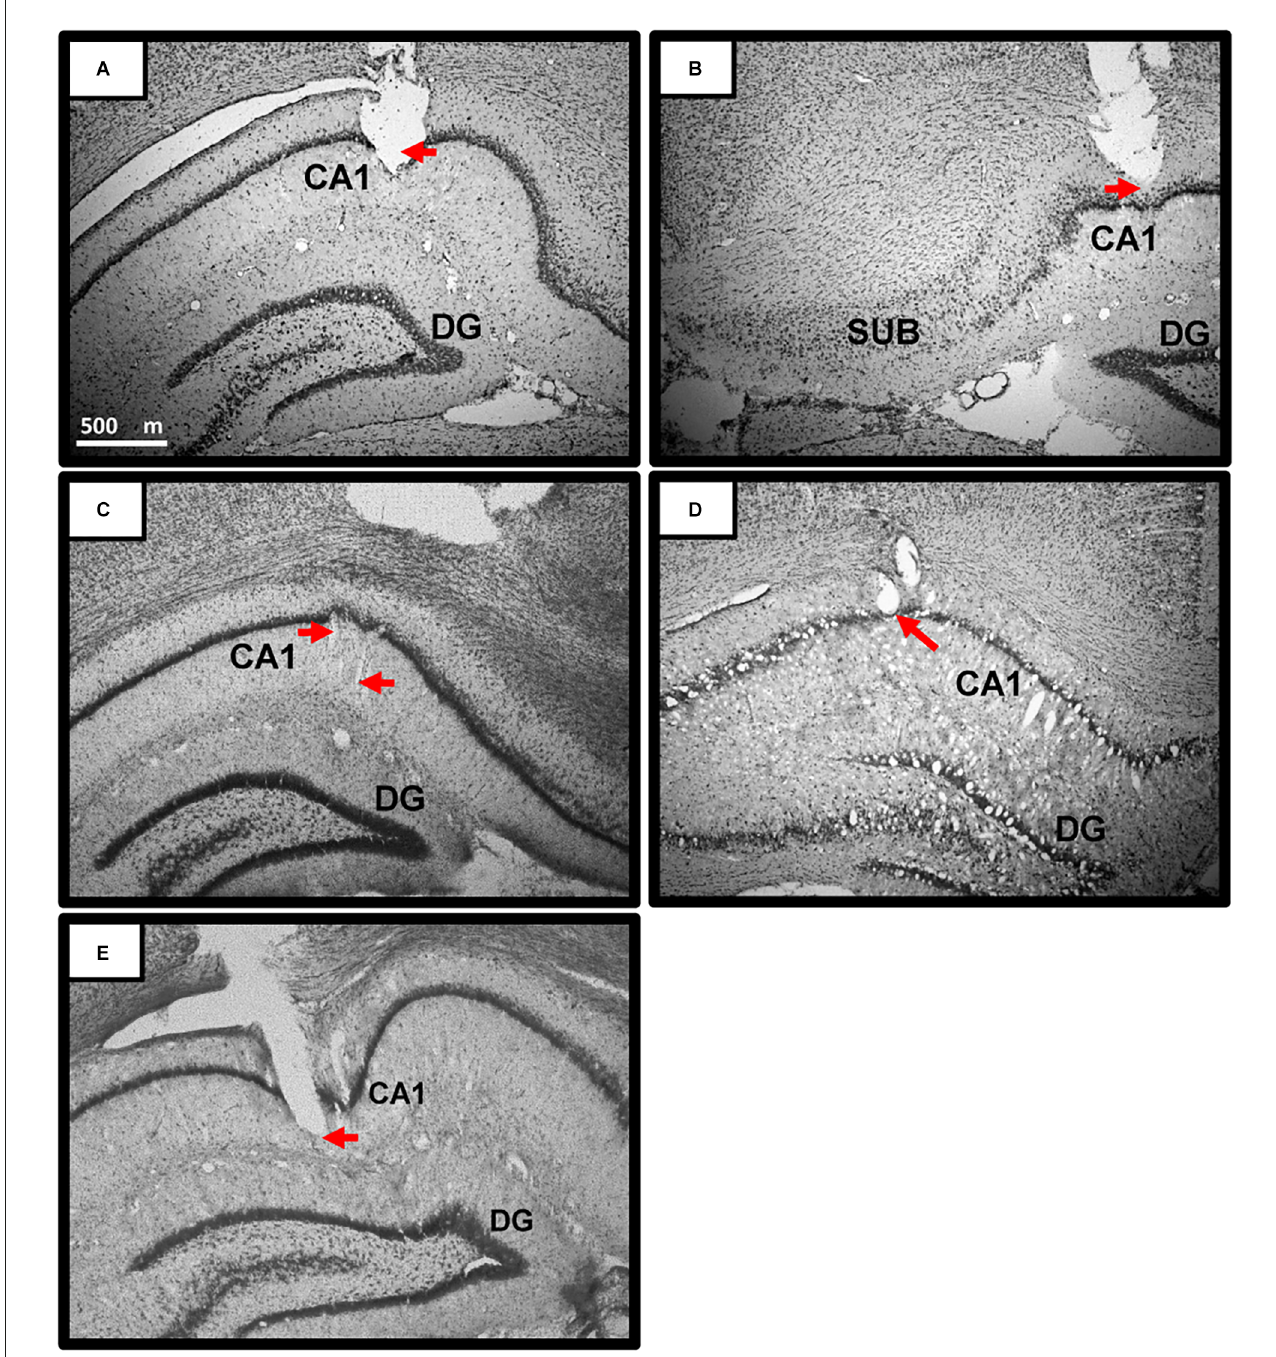
FIGURE4 Representative Theta Recording sites in CA1 of dorsal hippocampus. (A–E) Photomicrographs of coronal sections depicting representative recording sites in and around the pyramidal layer of the CA 1 region of the dorsal hippocampus. Red arrows point to estimated location of the tetrodes at time of recording. All dorsal-hippocampal tetrodes (four or eight per rat) were used to derive theta intercept and theta slope measures, with intercept and slope measures averaged to give a single value for each rat for each trial. Overall, estimated recording locations included all strata of CA1 (oriens, pyramidale, radiatum, and lacunosum-moleculare) from around − 3.0 mm AP to − 5.5 mm AP (-AP: i.e., behind bregma) along the anterior-posterior axis of the dorsal hippocampus. Scale bar in (A) applies to (A–E) . Rats: Rat 3 (A,B) ; Rat 4 (C) ; Rat 5 (D) ; Rat 6 (E) . Abbreviations: CA1, Cornu Ammonis1; DG, Dentate gyrus; SUB,